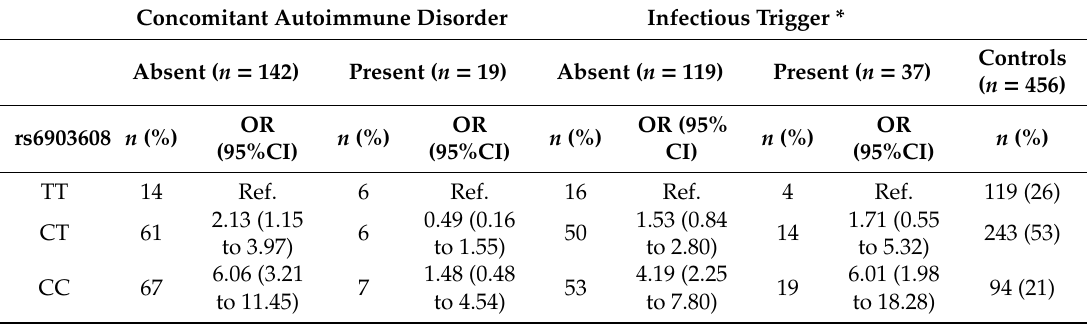
Table 4. Subgroup analyses by concomitant autoimmune disorder and infectious trigger preceding the acute event.